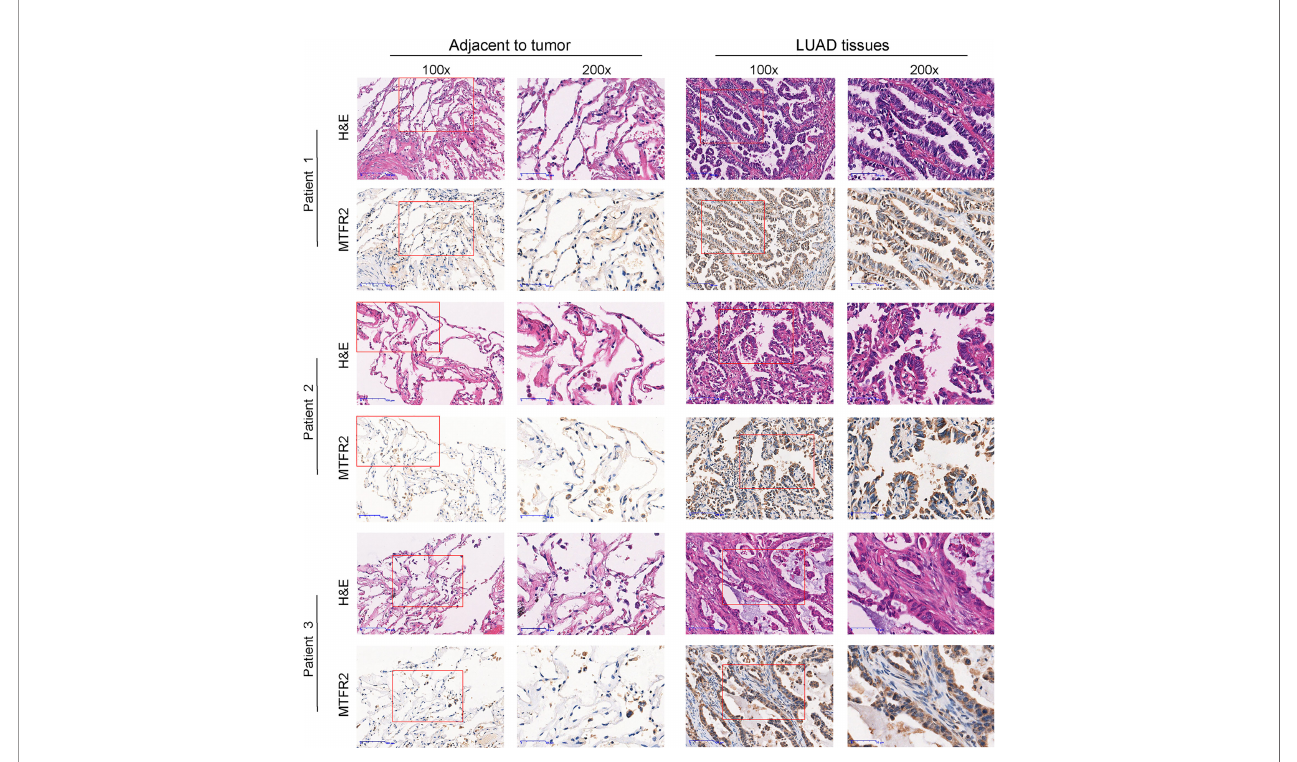
FIGURE 2 | MTFR2 was overexpressed in LUAD patients when compared to adjacent samples via IHC and H&E assay (×100,